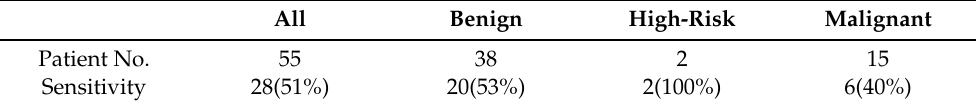
Table 3. Small Breast Analysis. All Benign High-Risk Malignant